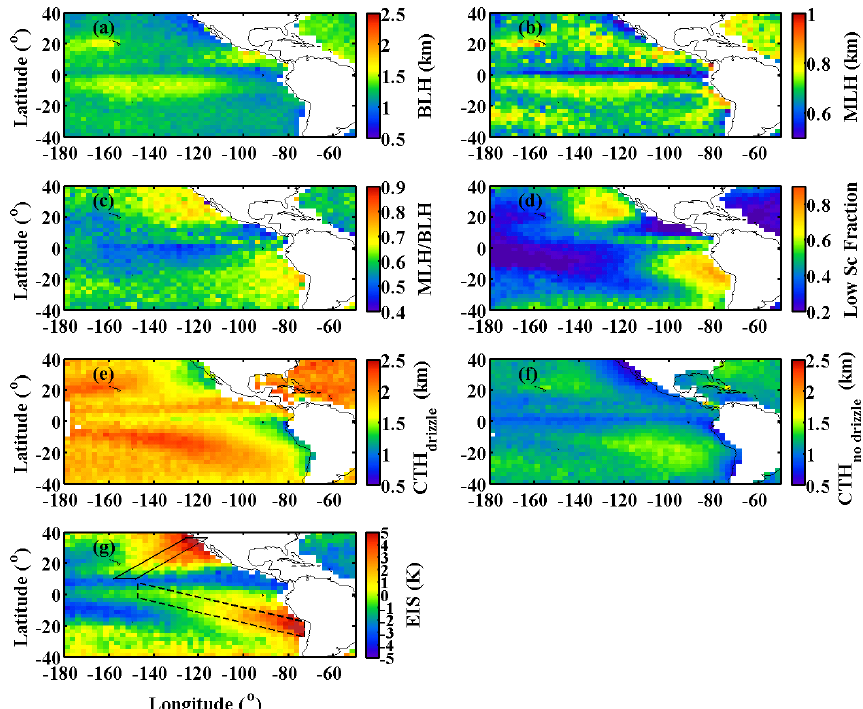
Figure 3. The spatial distribution of (a) CALIOP-derived BLH, (b) CALIOP-derived MLH, (c) CALIOP-derived MBL decoupling struc- ture in term of MLH / BLH, (d) marine low clouds fraction, (e) drizzled stratiform CTH (CTH drizzle ) , (f) non-drizzled stratiform CTH (CTH nodrizzle ) , and (g) EIS. The solid and dashed boxes in (g) denote the selected transects on the northeastern and southeastern Pacific Ocean (NPO and SPO) used in Figs. 4 and 5,